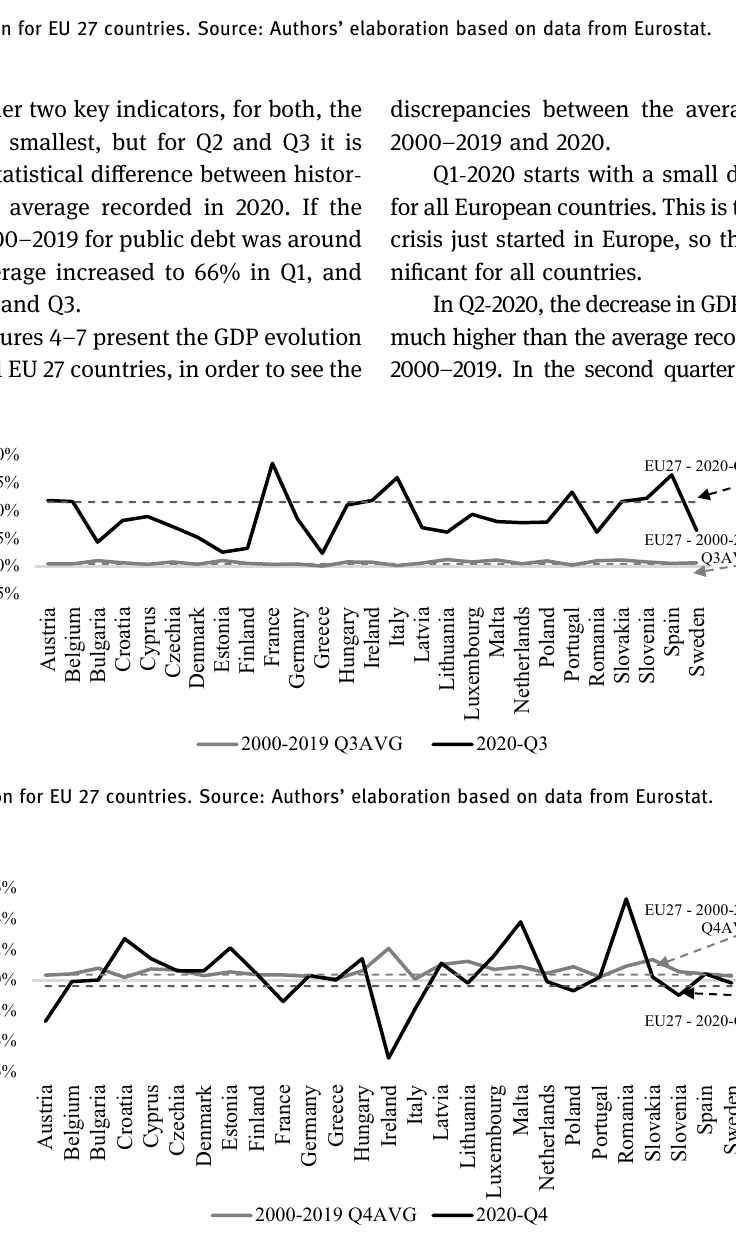
Figure 7: Q4 - GDP evolution for EU 27 countries. Source: Authors ’ elaboration based on data from